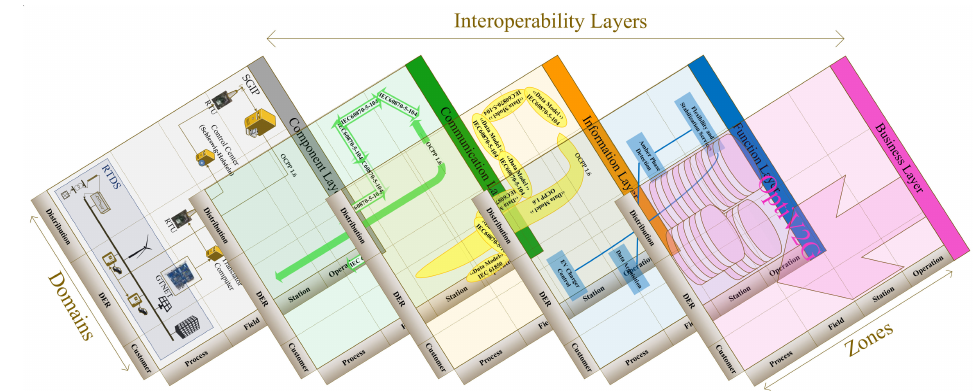
Figure 3. MEISTER SGAM